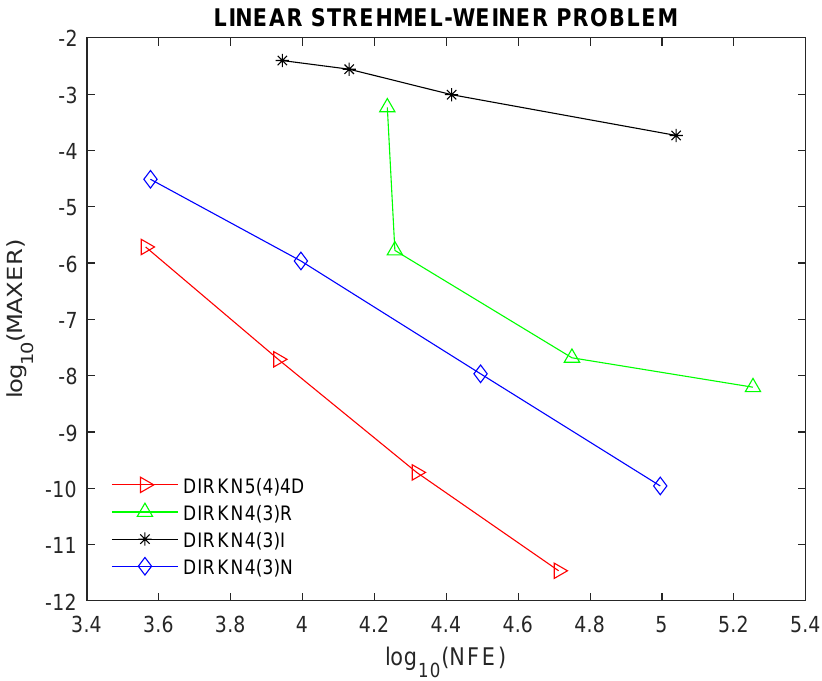
Figure 6. Efficiency curves for Example